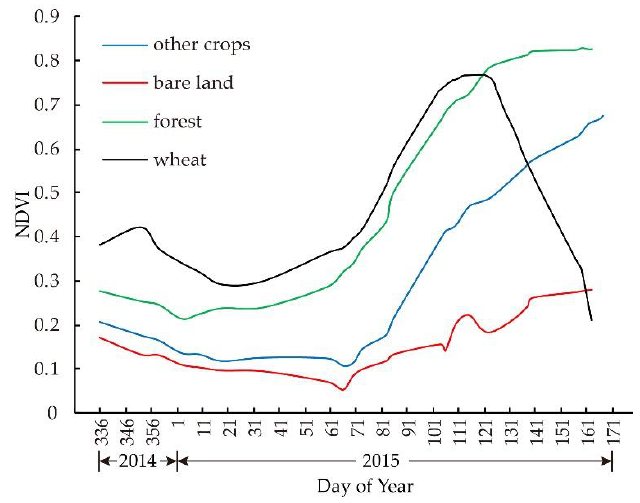
Figure 3. The reference normalized difference vegetation index (NDVI) time series of typical objects in the study area.